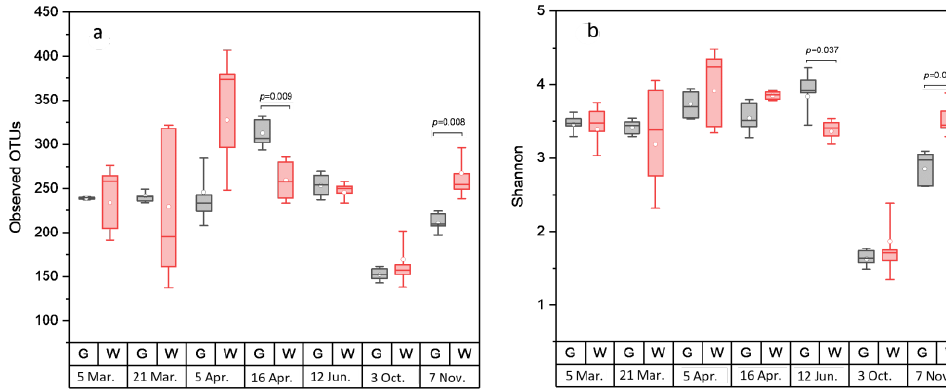
Figure 2. Alpha diversity of bacterial operational taxonomic units (OTUs) in the whole and gutted herring. The number of observed OTUs ( a ) and the Shannon index ( b ), attained from sequence data rarefied to 2219 reads. The boxes represent the interquartile range between the first and third quartiles. The horizontal line inside the box is the median and the white circle the mean, with the standard deviation obtained from the 4 to 6 parallel samples of gutted (G) or whole (W) fish. p -value is presented whenever a statistical difference in the mean values between the whole and gutted herring was found.